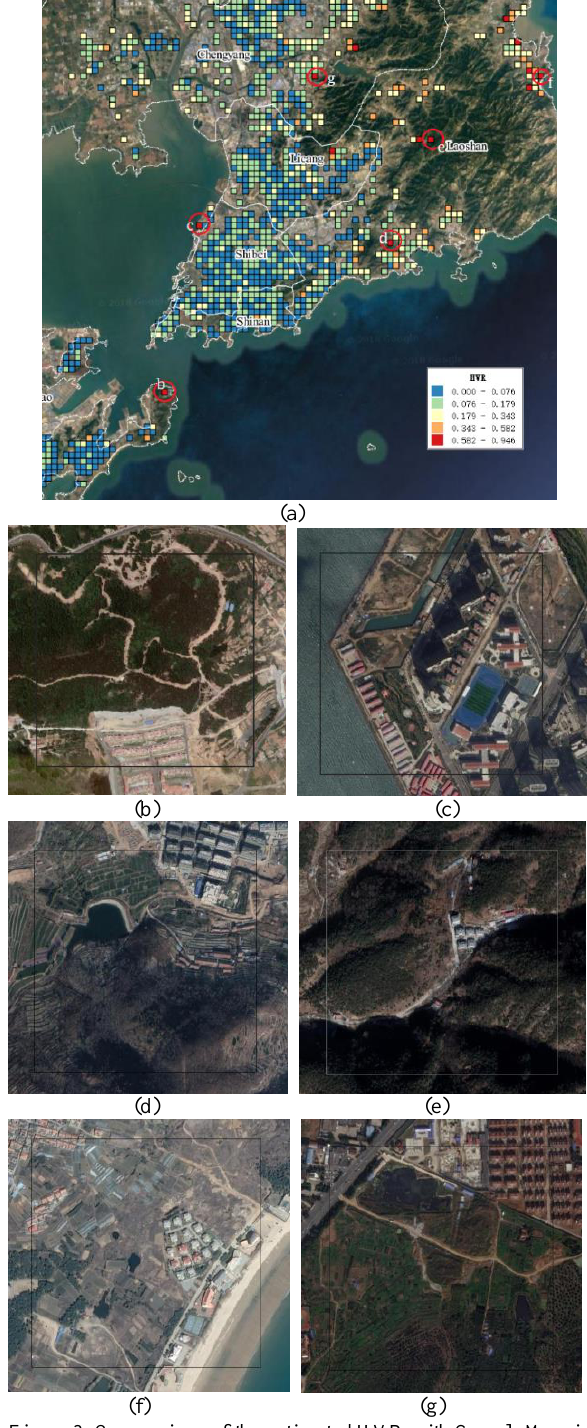
Figure 3. Comparison of the estimated HVR with Google Map in 2018. (a) shows the location of selected grids. (b), (c), (d), (e), (f) and (g) are zoomed aerial images of selected grids in (a).